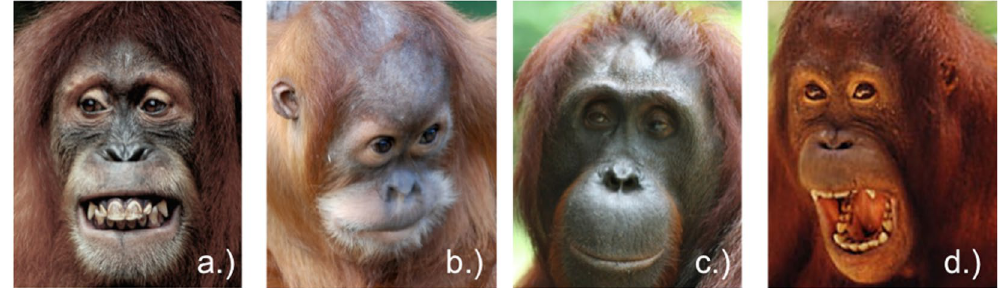
Figure 8. Orangutan stimuli. ( a ) Silent bared-teeth (SBT): AU10 (upper lip raiser) + AU12 (lip corner puller) + AU25 (lips part) 58 . AU combination of AU10 + 12 + 25 is described as silent-bared teeth display (SBT) for chimpanzees 55, 65 . ( b ) Bulging lip display (BL): Presence of AU24 (lip presser) 58 . Source: Prof. Dr. Katja Liebal. ( c ) Neutral face (NE): AU0 58 Source: Prof. Dr. Katja Liebal. ( d ) Relaxed open mouth (ROM): AU10 (upper lip raiser) + AU12 (lip corner puller) + AU25 (open mouth) + AU27 (mouth stretch). The playface is described for chimpanzees as AU combination AU12 + 25 + 26 55, 65 or AU12 + 25 + 27 65 . For gorillas the playface is described as AU16 + 25 + 26 and as „full playface“ within play context as AU10 + 16 + 25 + 26 68 . Source: Prof. Dr. Katja